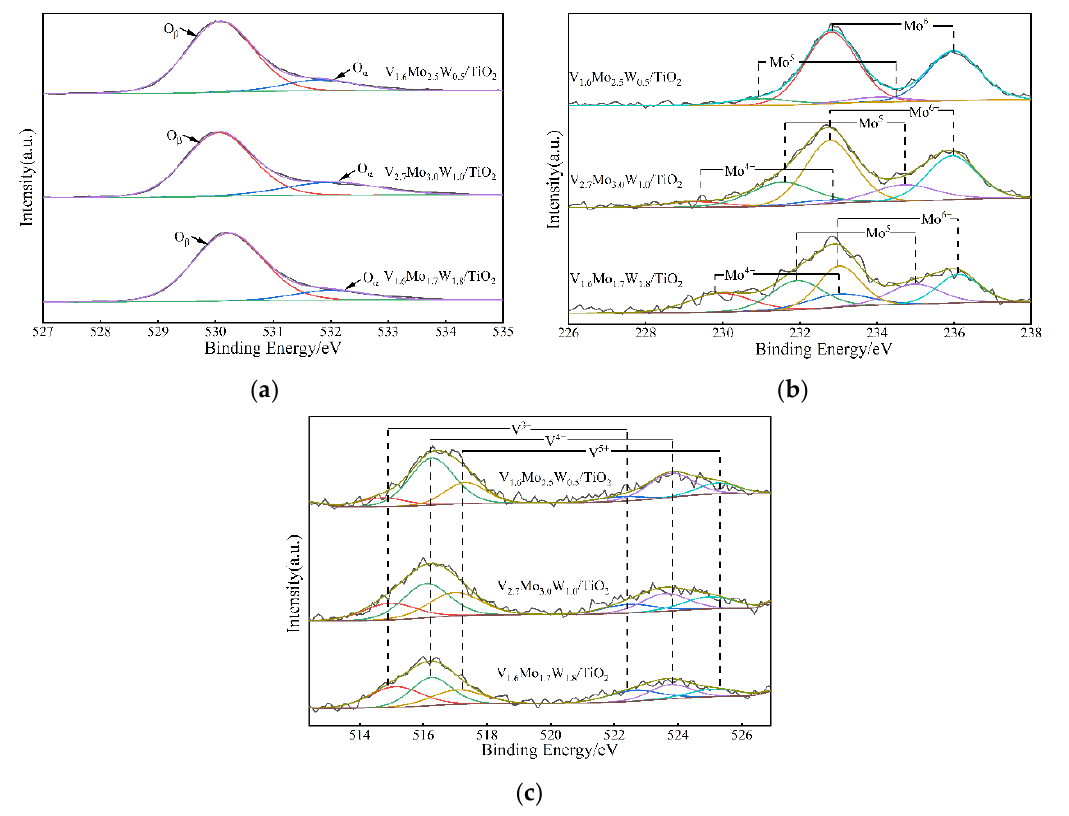
Figure 8. Deconvoluted XPS spectra of the three catalysts: ( a ) O1s; ( b ) Mo3d; ( c ) V2p. Table 2. The chemical states and the ratios of the relative concentrations of O, V, and Mo for different